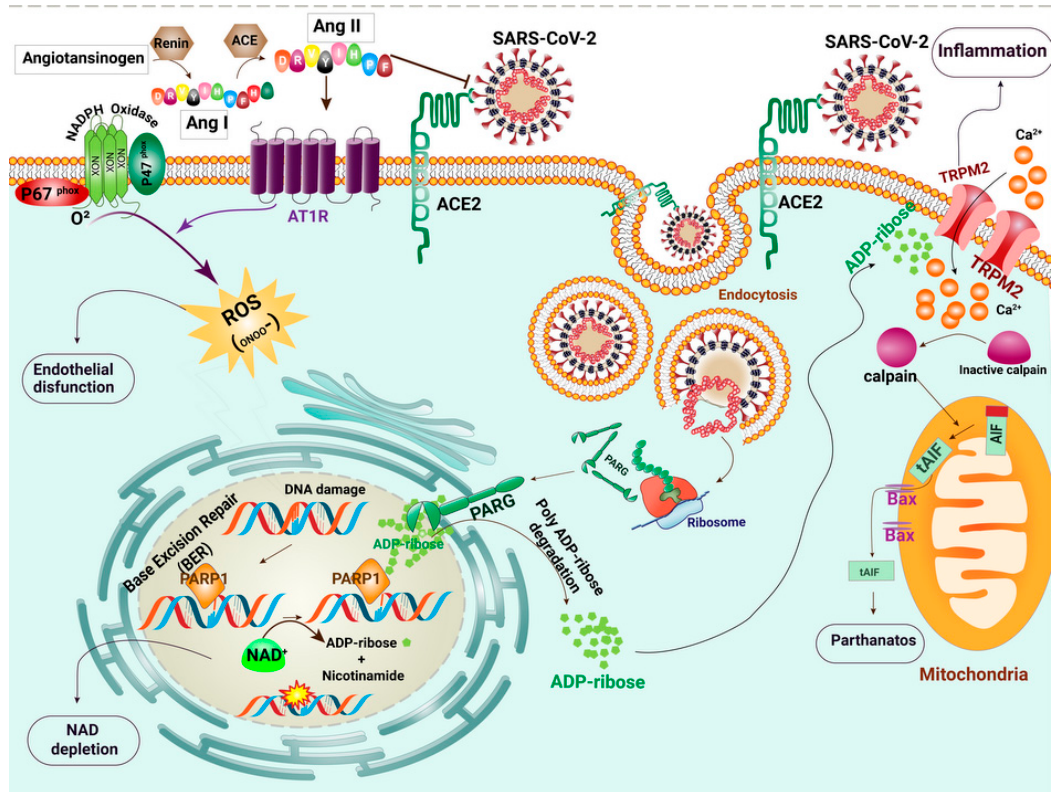
Figure 1. Schematic of the molecular events that occur in SARS-CoV-2 infected cells. SARS-CoV-2 forms a complex with angiotensin-converting enzyme 2 (ACE2) and enters cells via cell membrane-localized receptors. Receptor occupation by SARS-CoV-2 triggers ACE2 down-regulation and renin-angiotensin system (RAS) over-activation. Renin (REN) mediates the transformation of angiotensinogen (AGT) to angiotensin I (Ang-I). The angiotensin-converting enzyme (ACE) metabolizes Ang I to angiotensin II (Ang II). Because of the reduction in available ACE2, the angiotensin type I receptor (AT1R) is activated by the elevated Ang II. Subsequently, AT1R triggers a signaling cascade via activation of NADPH oxidase and induces intense oxidative stress. The produced ROS causes the breakage of DNA strands. Base excision repair (BER) plays a crucial role in repairing oxidative DNA damage via Poly(ADP-ribose) polymerase (PARP) activity. PARP undergoes auto-modification by transferring ADP-ribose on itself. Poly(ADP-ribose) glycohydrolase (PARG) is a protein encoded by Coronaviridae, which separates ADP-ribose units from PAR. Detrimental PARP and PARG activities lead to the accumulation of ADP ribose in the cytosol. Transient receptor potential channel melastatin 2 (TRPM2) channels are over-activated by direct binding of ADP-ribose and release a large amount of calcium ions (Ca 2+ ) to the cell. The intracellular Ca 2+ overload probably results in parthanatos, a form of programmed cell death that is distinct from other cell death processes such as necrosis and